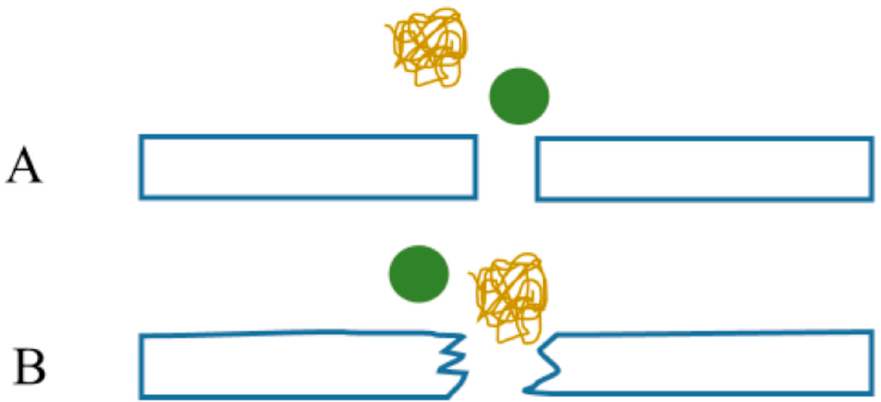
Figure 8. Schematic depiction of the membrane pore: ( A ) cylinder channel pore; and ( B ) tortuous pore.